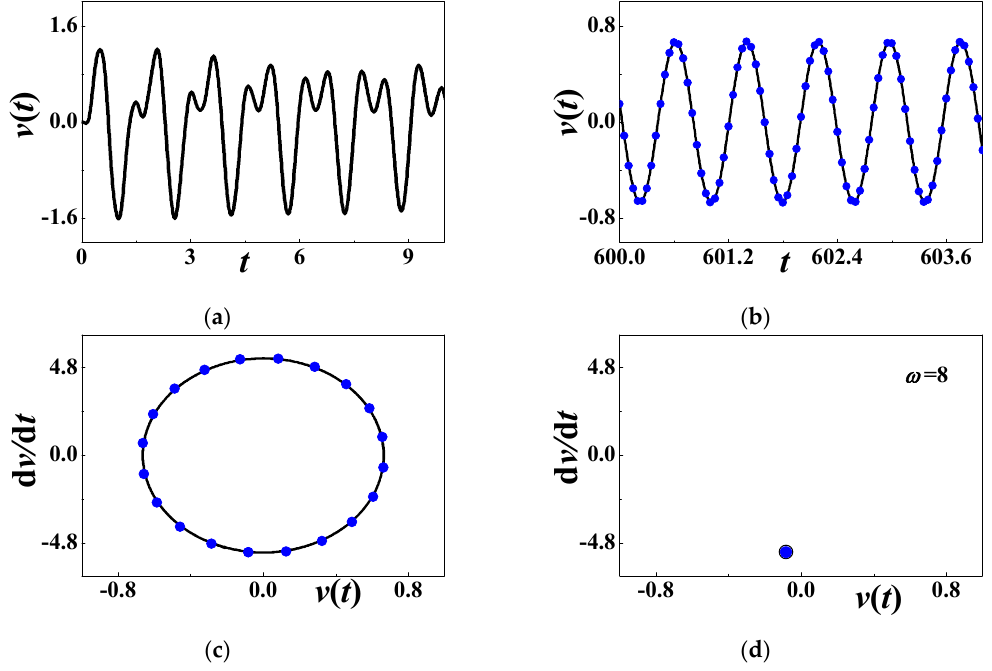
Figure 8. The periodic response when ω = 8: ( a ) initial history; ( b ) steady-state response; ( c ) phase diagram; ( d ) Poincare map. The solid blue dots stand for analytical prediction and others for numerical simulation.